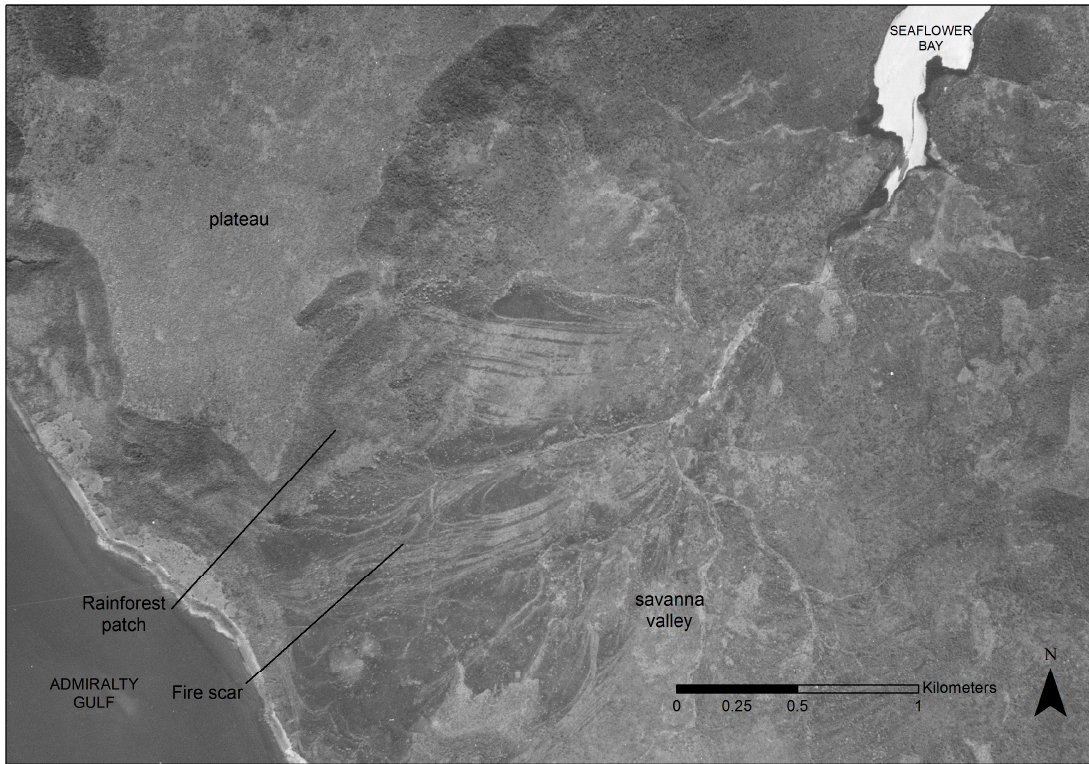
Figure 4. Aerial image of Seaflower Bay, the Bougainville Peninsula, June 1949 with a recent fire scar in a savanna valley in close proximity to a rainforest patch. The savanna valley contains cycad populations that were harvested as a food source by Aboriginal people.